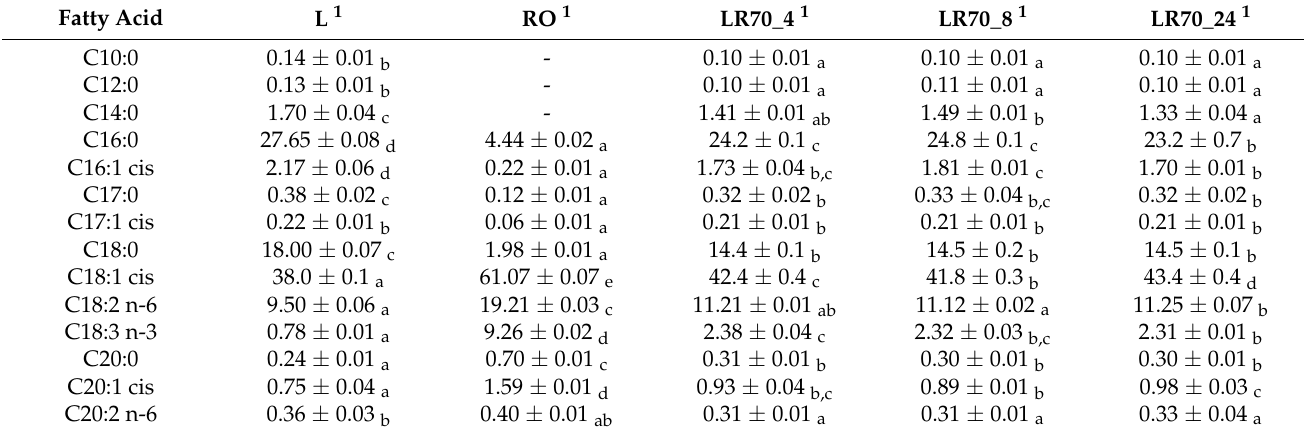
Table 1. FAs composition of raw materials and mixtures after interesterification (wt%).